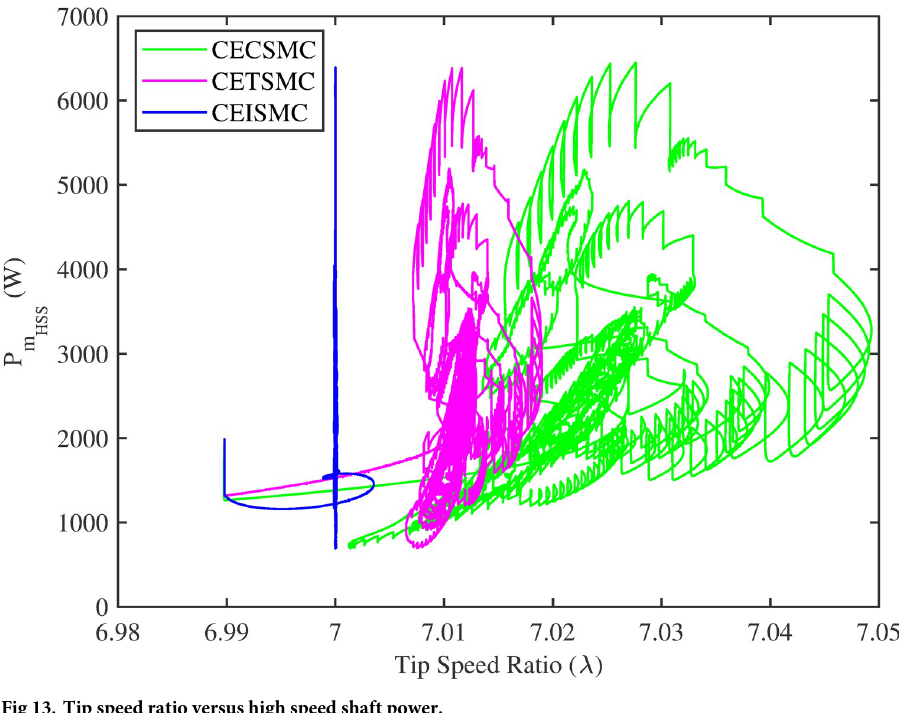
Fig 13. Tip speed ratio versus high speed shaft power.